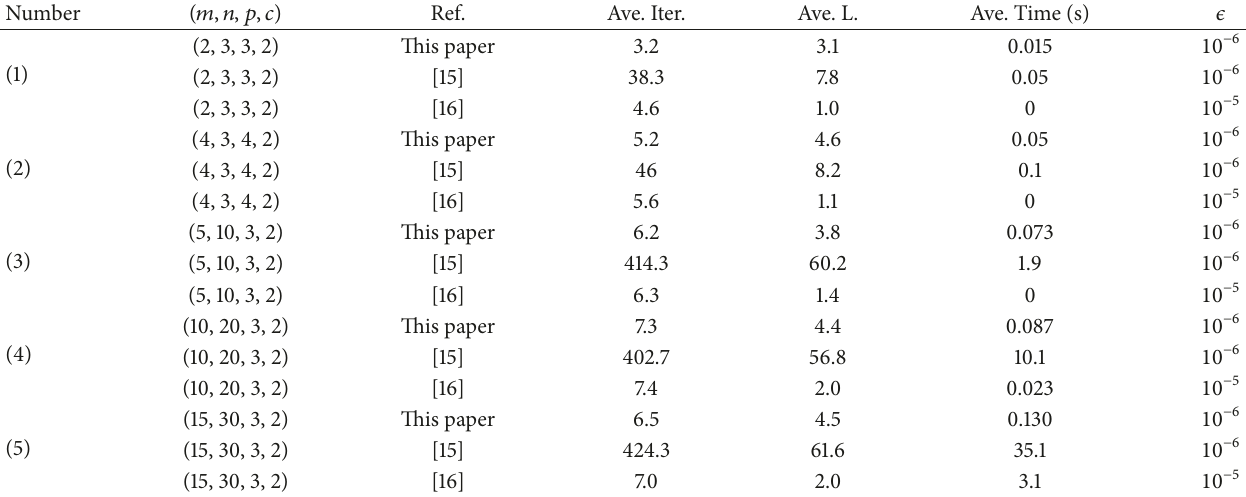
Table 1: Numerical results for test